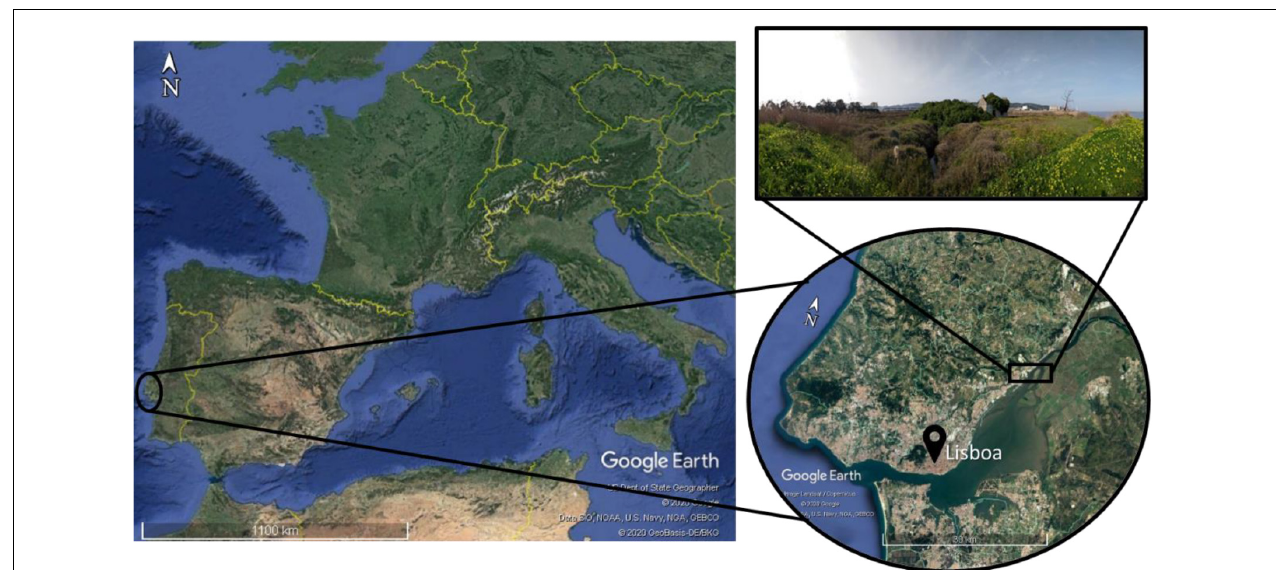
FIGURE 1 | The study area located in Sobralinho salt marsh area, on the right bank of the river Tagus, in the Municipal Council of Vila Franca de Xira, west Portugal.